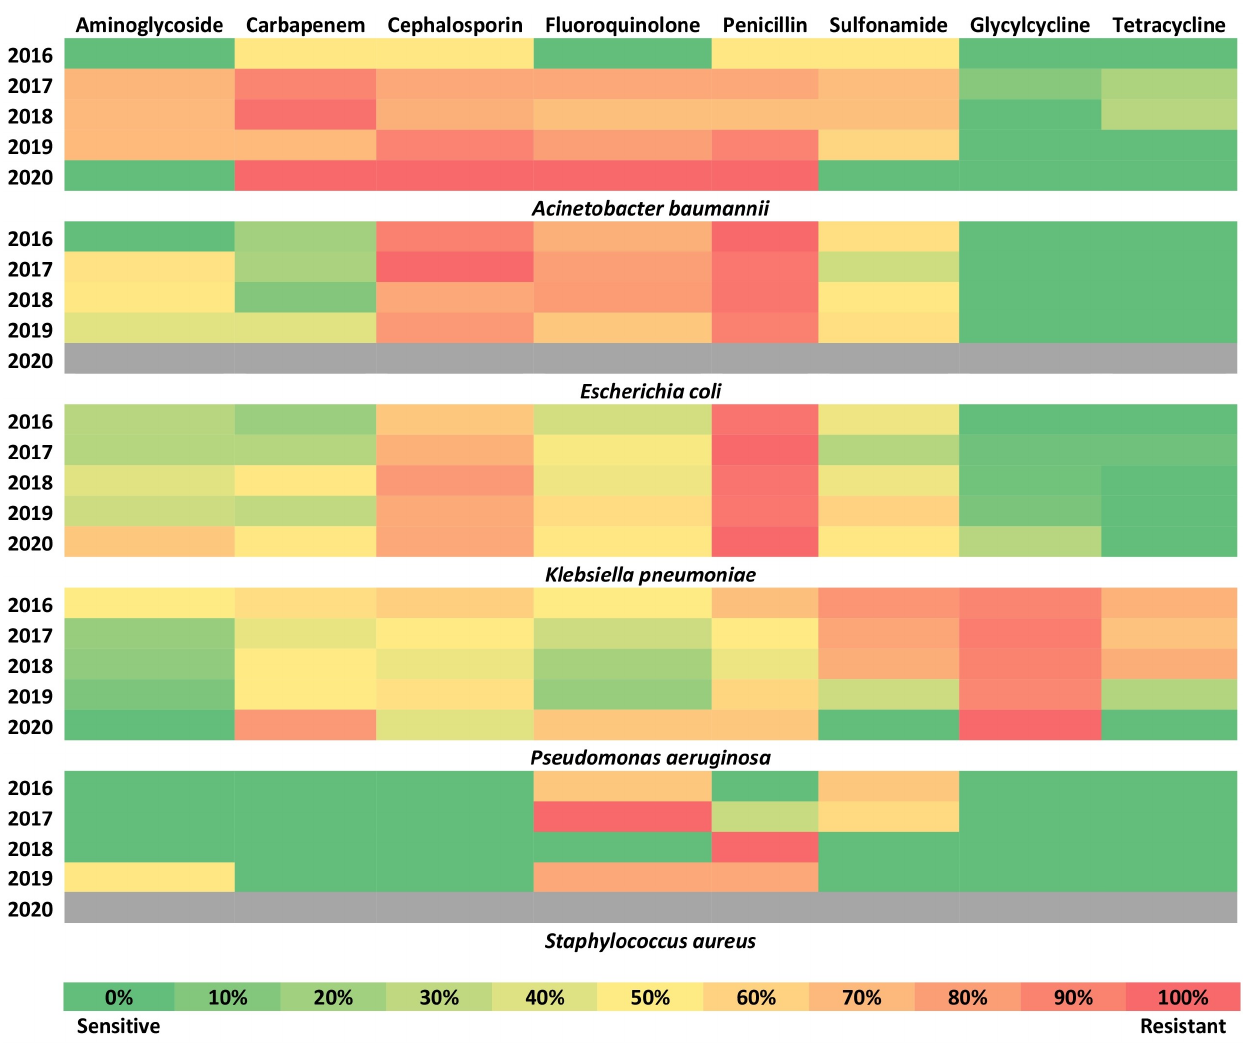
Figure 6. Trends of the isolates ( Acinetobacter baumannii , Escherichia coli , Klebsiella pneumoniae , Pseudomonas aeruginosa , and Staphylococcus aureus ) resistant to different antibiotic classes. Glycylcycline remained the most sensitive drug over the years for Acinetobacter baumannii . Glycylcycline and tetracycline remained the most sensitive drugs over the years for Escherichia coli . Tetracycline remained the most sensitive drug over the years for Klebsiella pneumoniae . Aminoglycosides were the best class of drugs over the years for Pseudomonas aeruginosa. (Note: No Escherichia coli and Staphylococcus aureus were isolated in 2020 which was due to the COVID-19 pandemic which led to fewer patient admissions and in turn fewer culture-positive patients).